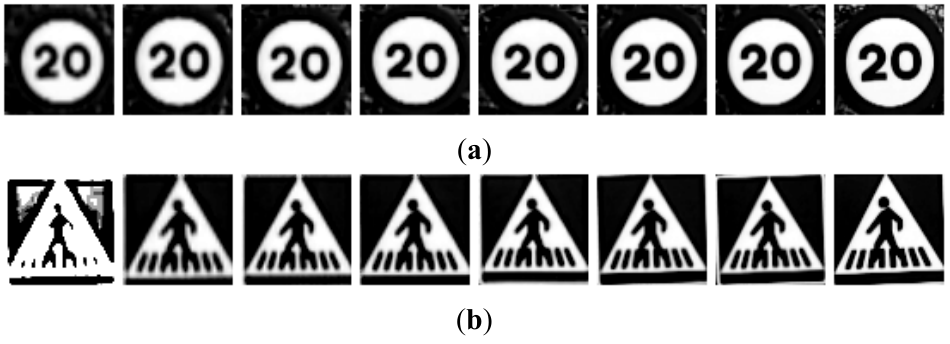
Figure 5. Examples of candidates in Figure 3 when histogram stretching is applied ( a ) Red road signs. ( b ) Blue road signs.